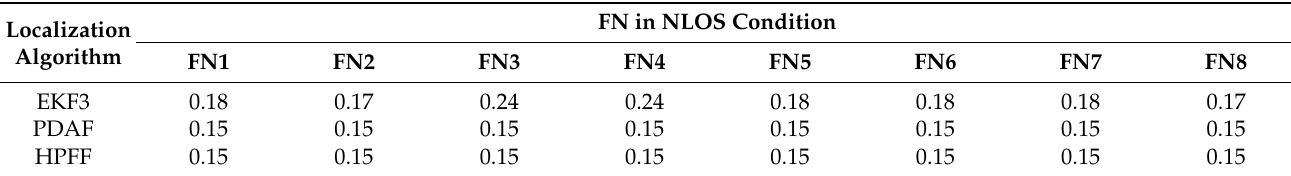
Table 1. RTAMS position errors (unit: meter) in temporary NLOS conditions.